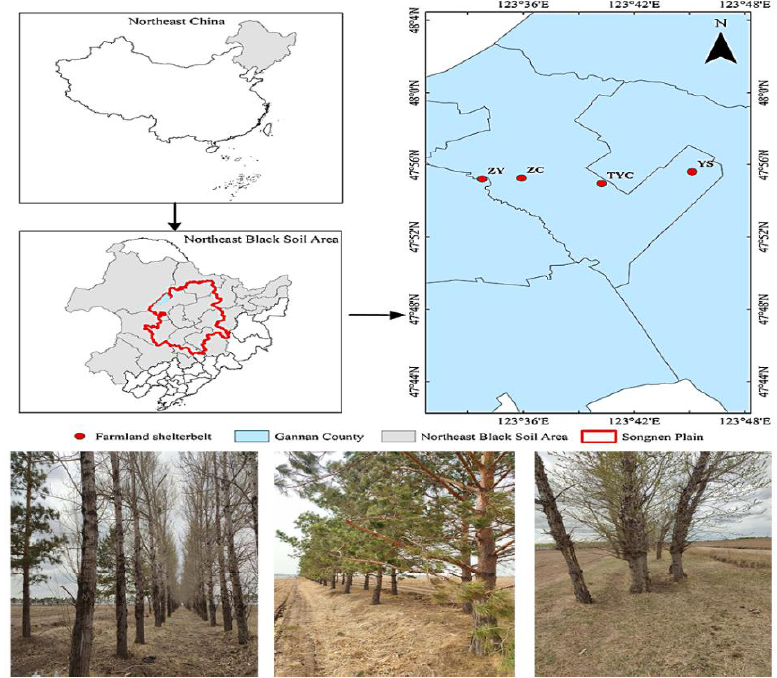
Figure 1. Research region and sample site.